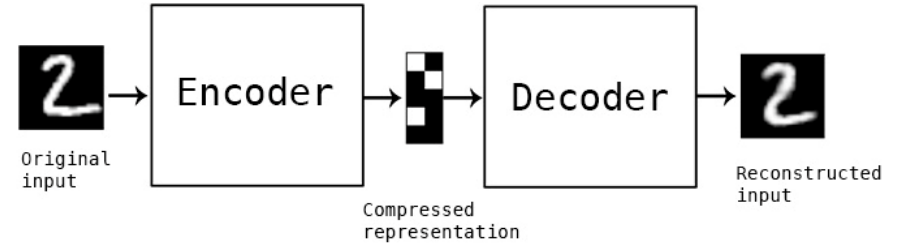
Figure 5. Illustration for an autoencoder architecture [39] .